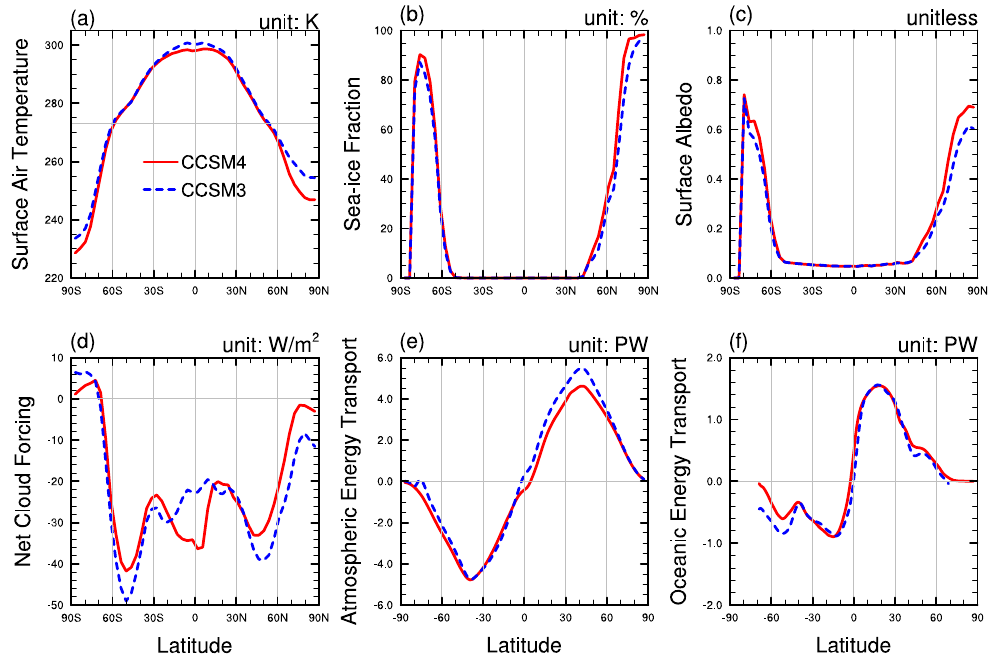
Fig. 1. CCSM4 (solid line) vs. CCSM3 (dashed line) for the pre-industrial control simulation. Annual and zonal mean surface air tempera- ture (a) , sea ice fraction (b) , surface albedo (c) , in this calculation, the land grid cells are excluded, net cloud radiative forcing at the top of the model ( (d) , longwave plus shortwave), northward atmosphere energy transport (e) and ocean energy transport (f) . For ocean energy transport, in CCSM4 it includes the Eulerian mean and parameterized eddy, submesoscale and diffusive contributions, while the corresponding CCSM3 transport is for Eulerian mean component only.